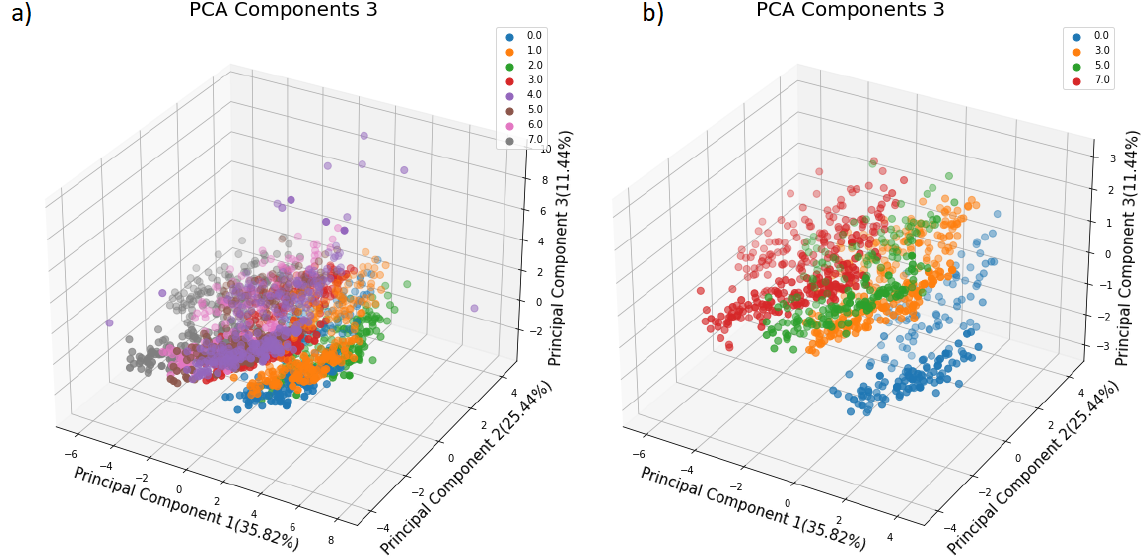
Figure 6. Three Components PCA model: ( a ) PCA applied to all samples. ( b ) PCA applied only to four samples WaterPvP0, WaterPvP3, WaterPvP5 and